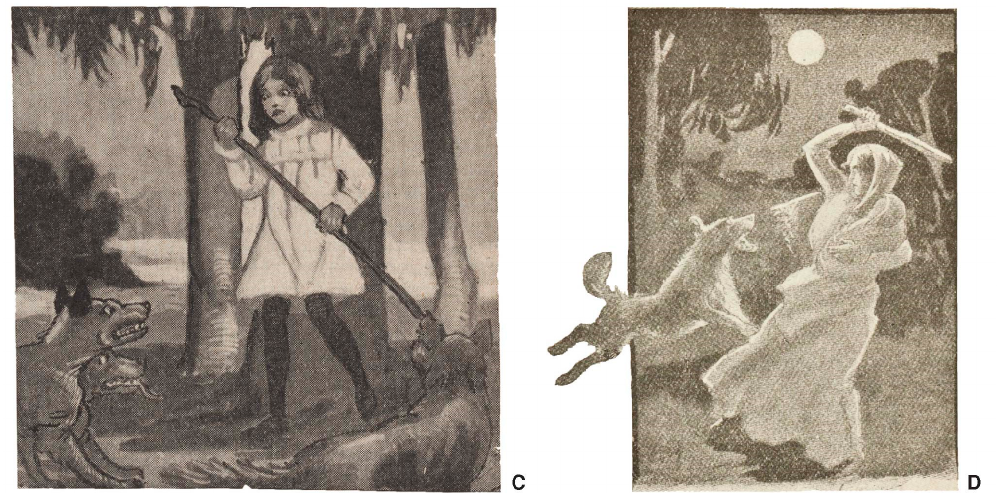
Figure A1. Early representations of dingoes attacking humans. Some images relate to historical accounts of dingo attacks ( A , B ), and thus purport to be factual, while others are from fictional stories ( C , D ). ( A ) Dingoes attacking a lone rider. This incident reportedly took place in the Para River region in the mid-19th century [81] (Table A1); ( B ) A pair of dingoes ‘treeing’ a woman. Published in the Bulletin in 1884 (redrawn from the original using the Adobe Illustrator Live Trace tool (setting: Default)), this image was based on a contemporary account (1884) of an incident that occurred in the Dawson River area: a young female cattle drover was supposedly chased up a tree by a pair of dingoes when she intervened in their attempt to kill some cattle [210] (Table A1). In fitting with the gender stereotyping of the late Victorian era the cattlewoman has been improbably represented as a coquettish ing é nue in an elegant dress; ( C ) Dingoes cornering a lost child. This is an illustrated scene from the fictional story of ‘Warrigal’ the wild dingo [211] (p. 48). Here, the young daughter of a selector, who had strayed into the wilderness, is surrounded by hungry wild dingoes. In the climax of this narrative the story’s antihero, Warrigal, scares away the predatory dingoes and keeps the child safe until she is rescued; ( D ) A dingo attacking a settler woman and baby. This image by an unknown artist accompanied a 1920 fictional story set in colonial New South Wales [212]. All images are out of copyright. Sources: ( A ) ‘The Dingo Or Native Dog’ (artist: Walter Hart (27 July 1866)). Reproduced with the permission of the State Library Victoria; ( B ) Title: ‘Tree’d by dingoes: a pretty girl on the Dawson River, Queensland, takes refuge from the attentions of native dogs of too much taste’ [210]. ( B – D ) Reproduced with the permission of the National Library of